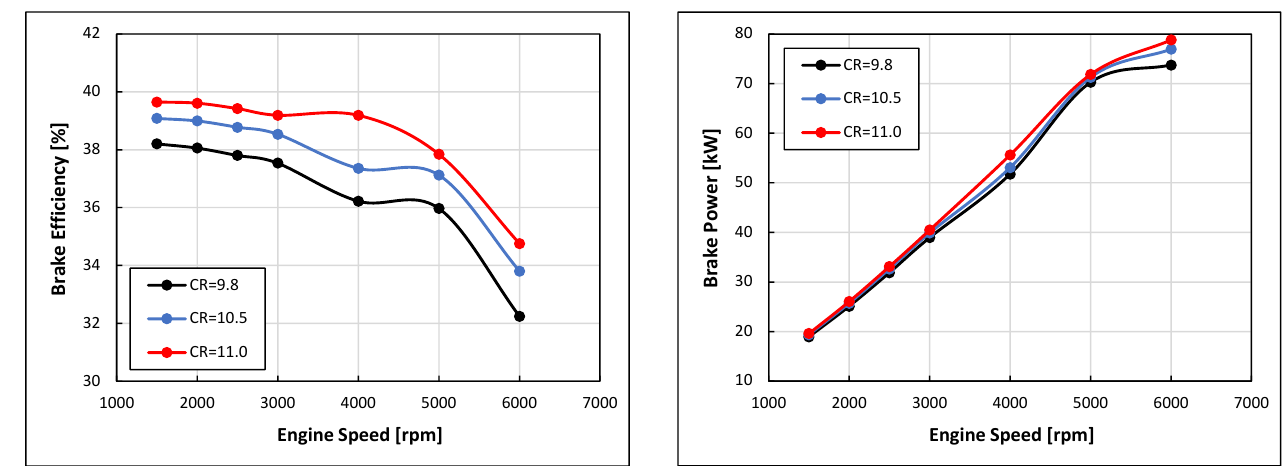
Figure 12. Brake efficiency ( left ) and brake power ( right ) for different compression ratios. ϕ = 1, WOT, no boost.